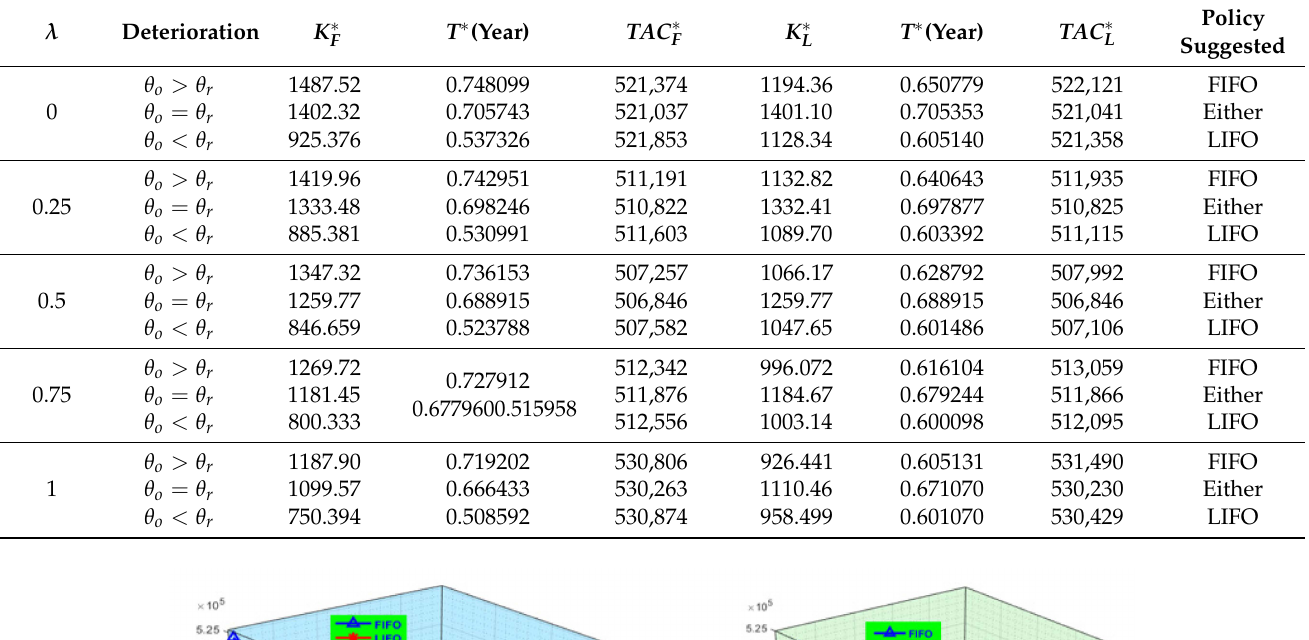
Table 8. Optimal cost of inventory system for different interval-valued parameter λ .